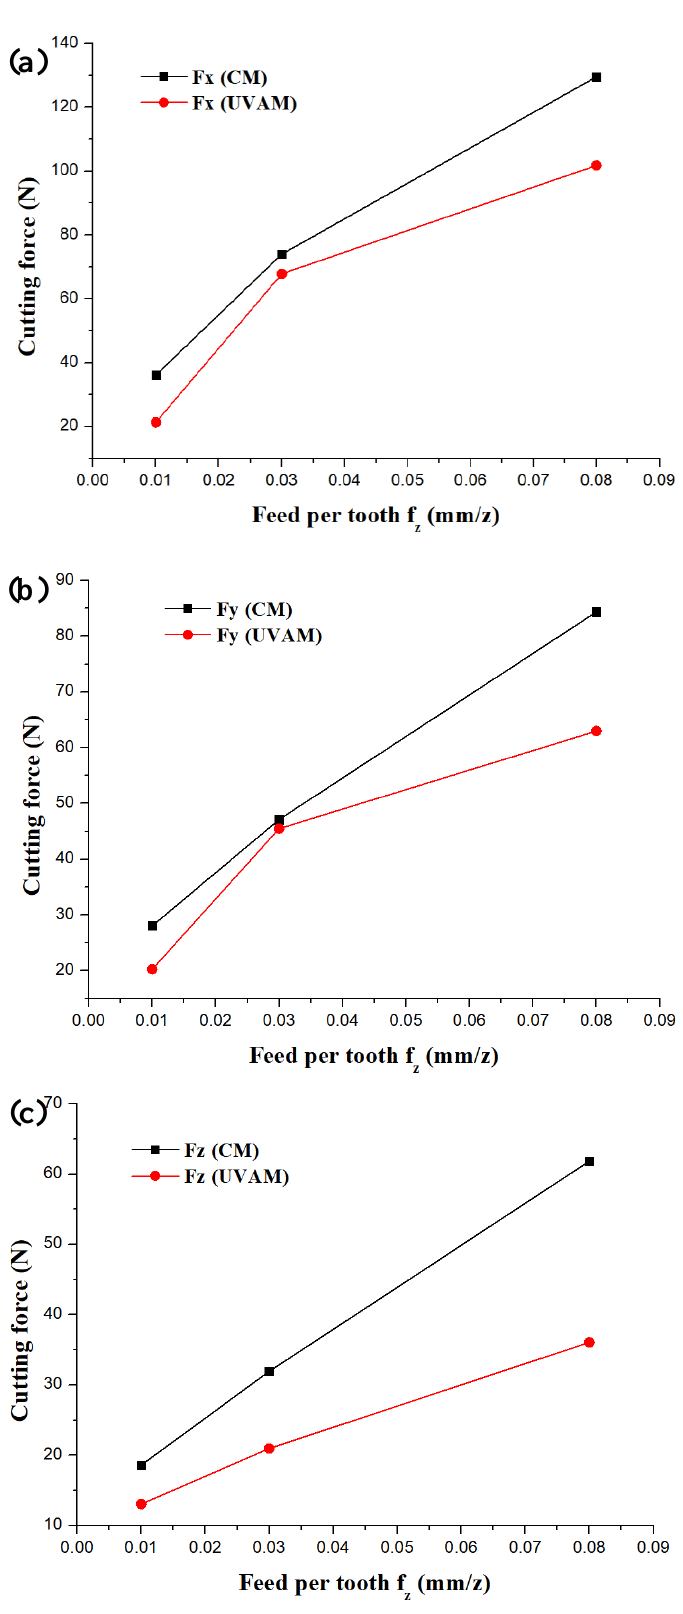
Figure 2. Influence of f z on the cutting force of CM and UVAM. ( a ) changing trend of Fx, ( b ) changing trend of Fy, ( c ) changing trend of Fz.